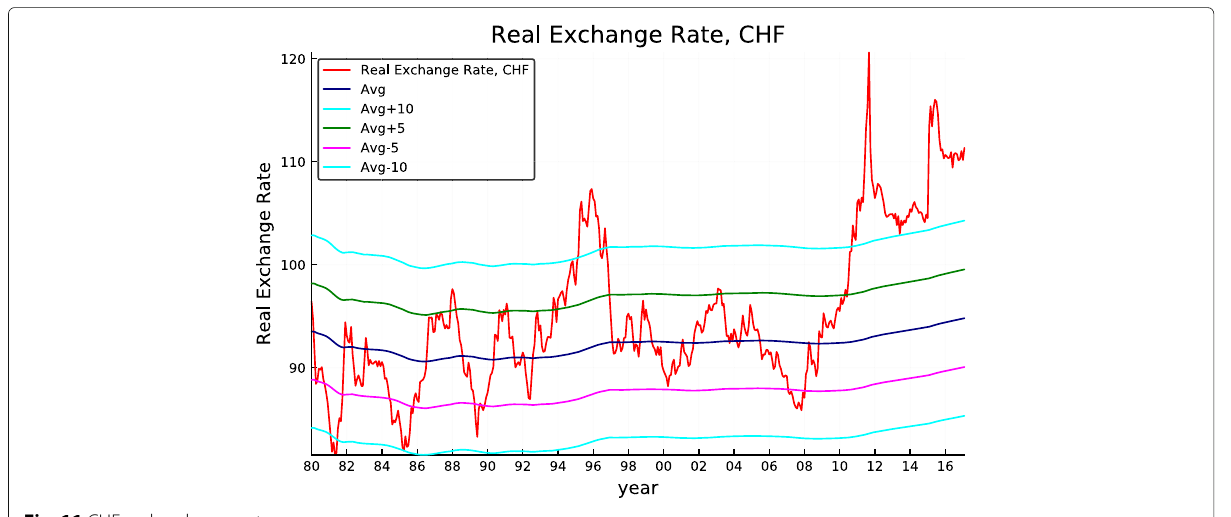
Fig. 11 CHF real exchange rate